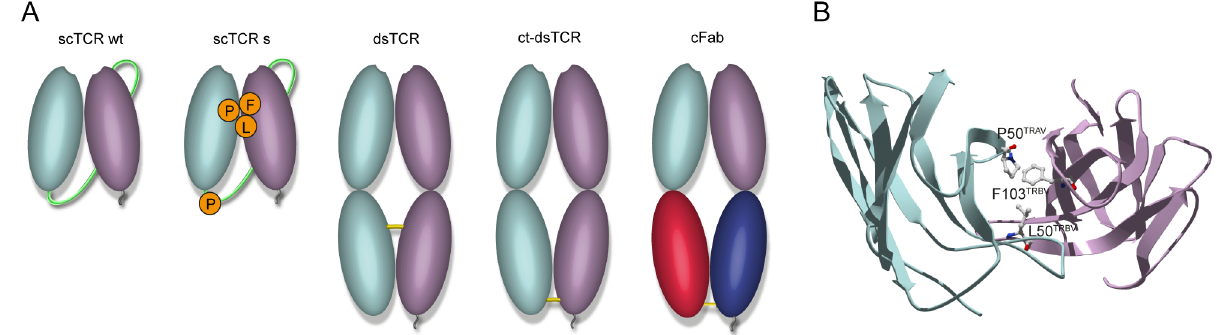
Fig 1. Overview of the TCR formats and triad of amino acids that form a stabilized interphase. (A) Schematic presentation of the TCR formats. From left to right; scTCR wt, scTCR s, dsTCR, ct-dsTCR and cFab. TCR α - and β -chains are colored pale green and purple, respectively, and C H 1 and C κ of the cFab are colored red and blue, respectively. The V α /V β domains of the scTCRs are connected via a peptide linker as shown in green. Disulfide bonds are illustrated in yellow and the c-Myc and His6 -tags are shown in grey. (B) Top-down view of the amino acids forming the V α /V β interphase triad, P50 TRAV , L50 TRBV and F103 TRBV . The crystal structure of the HLA-DQ2.5-DQ2.5-glia- α 2-specific TCR S16 was used for modelling the triad (PDB ID 4OZH)